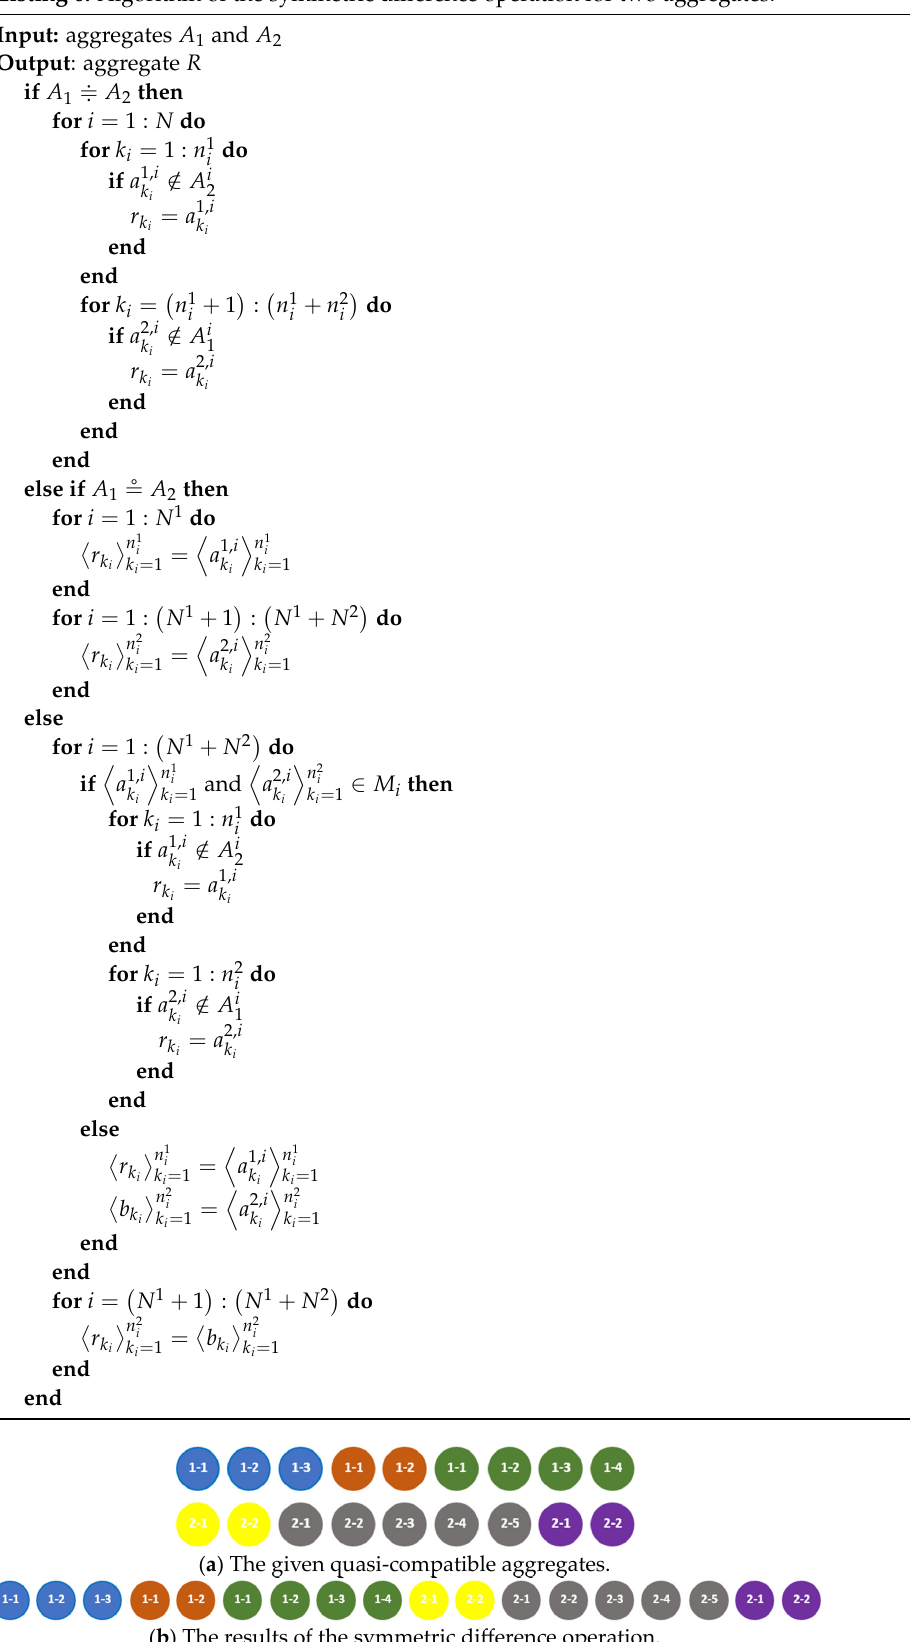
Figure 15. An example of applying the symmetric di ff erence operation to two incompatible aggre- gates.